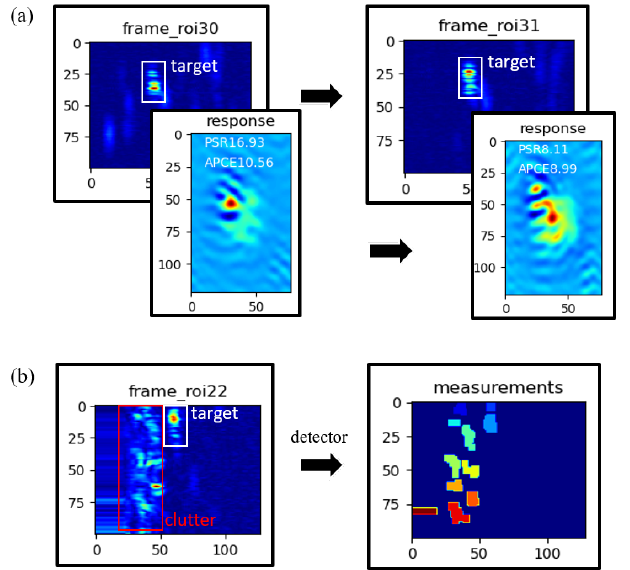
Figure 2. Common challenging situations. ( a ) Appearance changing. ( b ) Interruption